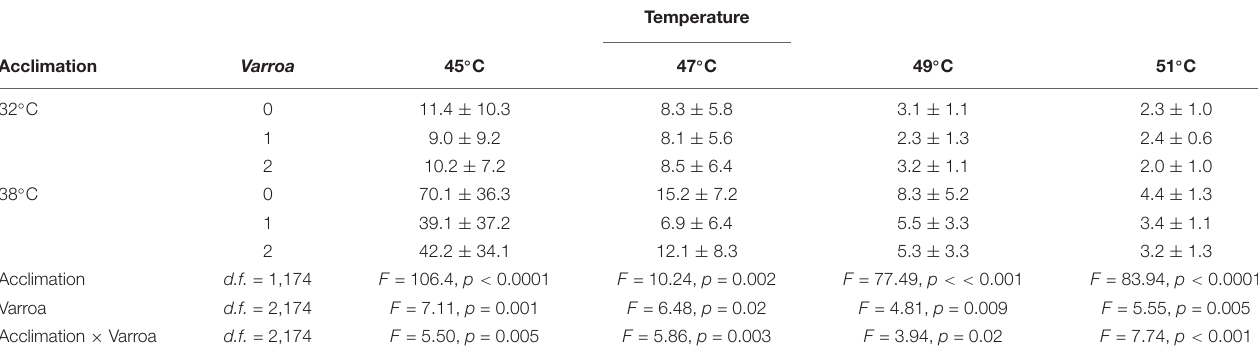
FIGURE 2 | Heat tolerance in honeybees acclimated to 32 and 38 ◦ C and exposed to different levels of parasitism by Varroa , expressed as thermal death time (TDT) curves. Parameters CT max and z represent, respectively, the thermal tolerance following an exposition of t = 1 min (i.e., the temperature that intercepts the abscissa) and the temperature difference required to increase t by one order of magnitude (see main text). Symbols in blue and red represent, respectively, acclimation temperatures of 32 and 38 ◦ C. Values are shown as mean ± SE. TABLE 1 | Survival times (min) employed to estimate the thermal death time (TDT) curves for different treatments ( n = 180 for each